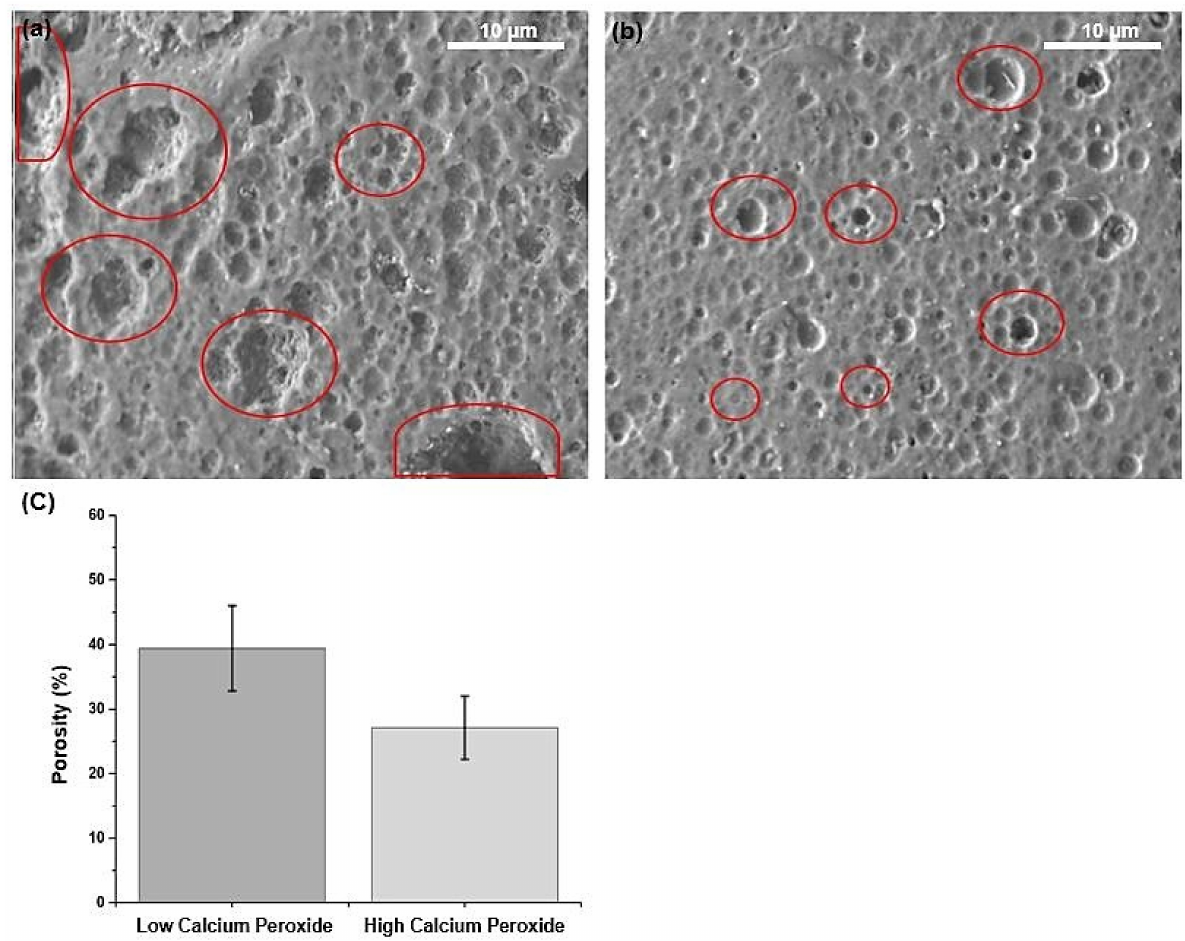
Figure 7. The effect of calcium peroxide on polylactic acid porosity. SEM images of the filament sur- face after degradation, showing porosities at ( a ) high and ( b ) low calcium peroxide at a magnification of × 2500 and an energy of 5.0 keV. ( c ) a semi-quantitative analysis of filament porosity based on image analysis ( n =